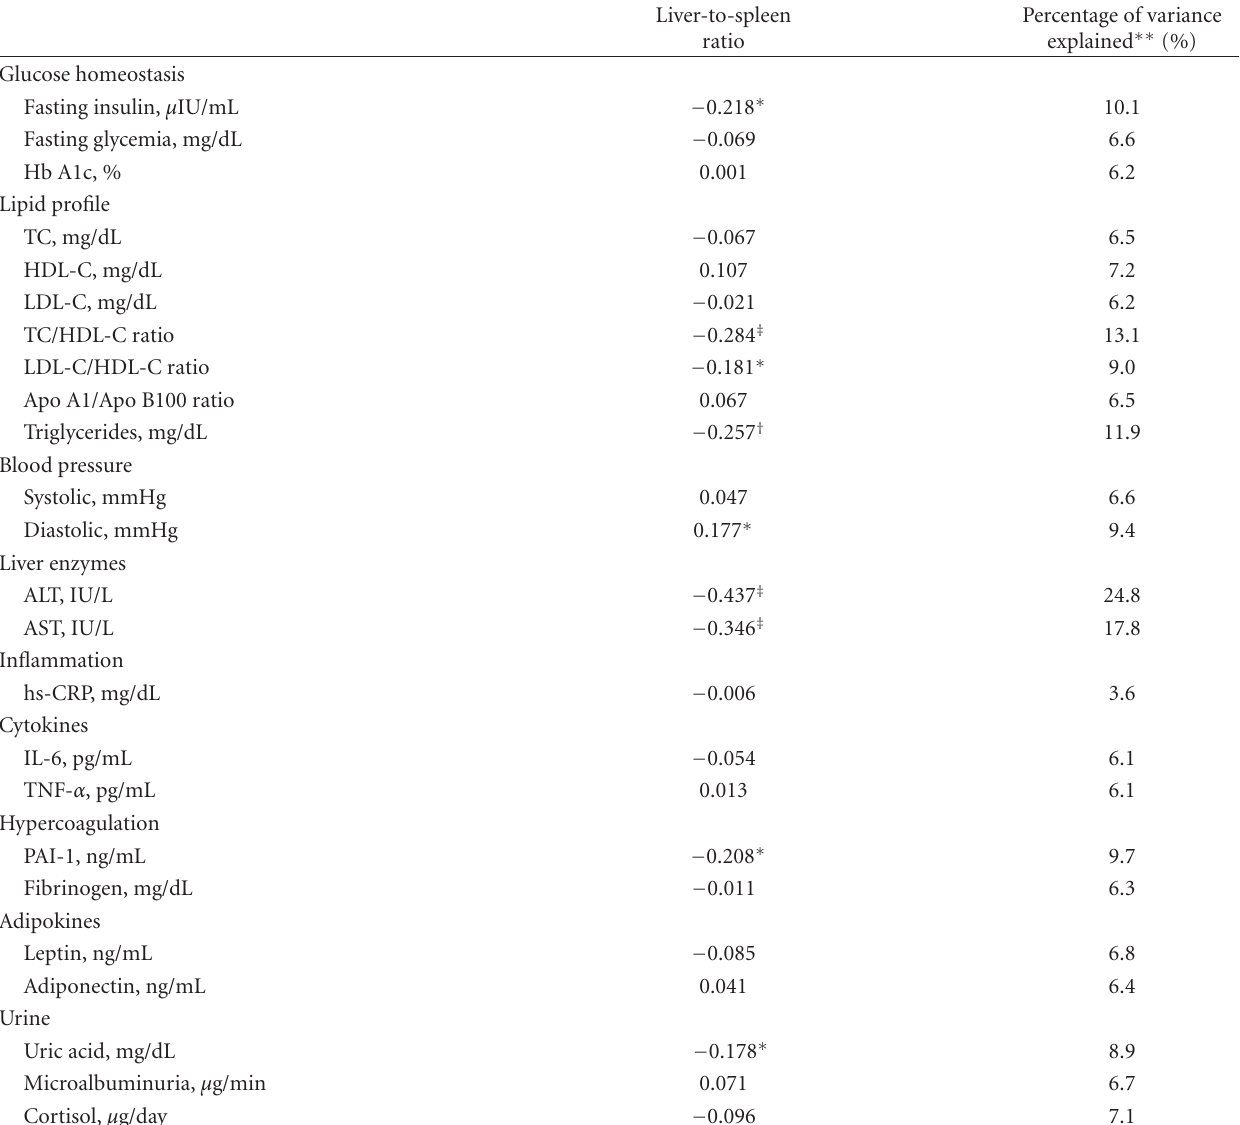
Table 5: Independent contributions (standardized beta coe ffi cients) of metabolic syndrome components to liver-to-spleen ratio, adjusted for age and